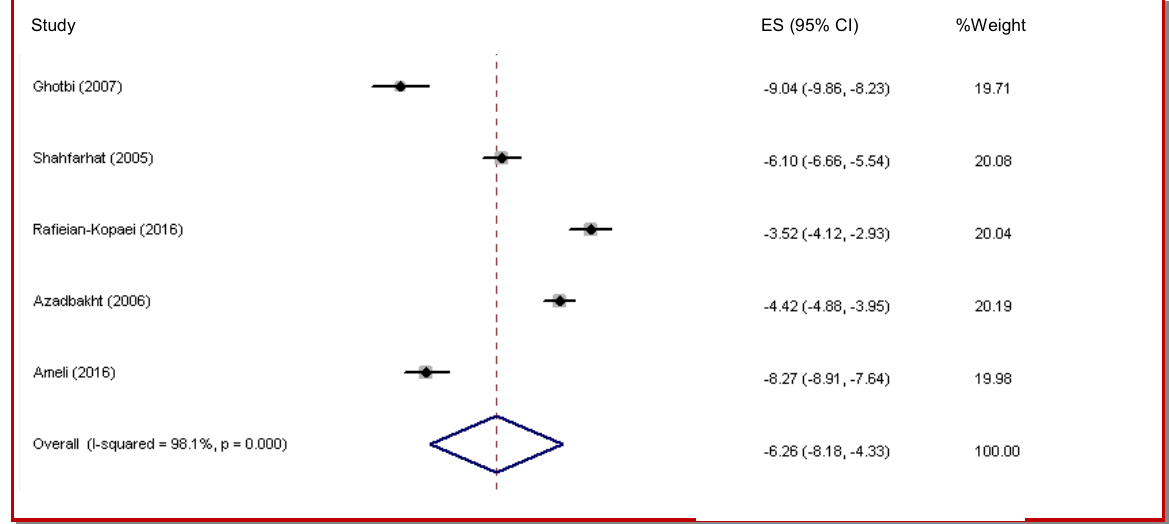
Figure 4: Forest plot Standardized Mean Difference (Hedges method) of within intervention arm (cotoneaster and phototherapy) in 36 hours after the intervention versus baseline